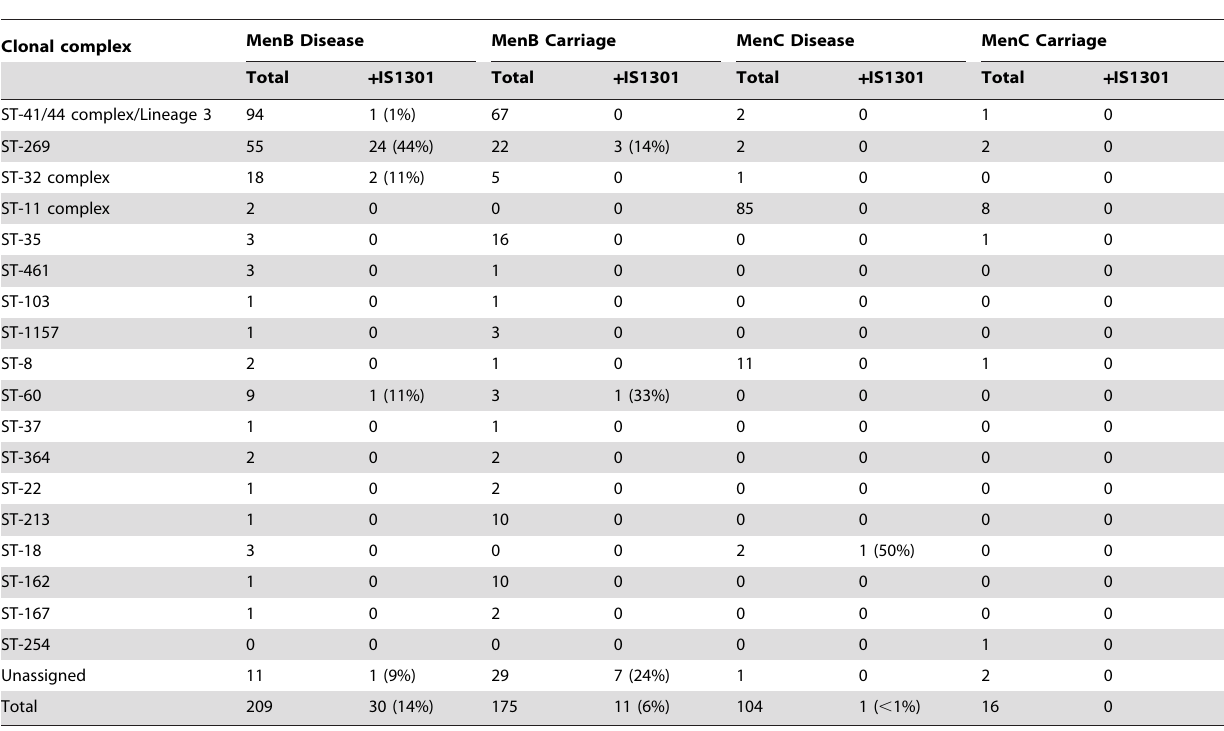
Table 2. Presence of IS1301 in the IGR of MenB and MenC isolates from different clonal complexes.